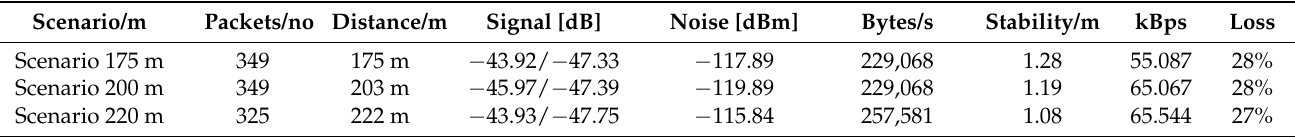
Table 6. Simulation scenarios over a distance of more than 200 m from reception, data interpretation, loss, data transfer, signal, and noise.